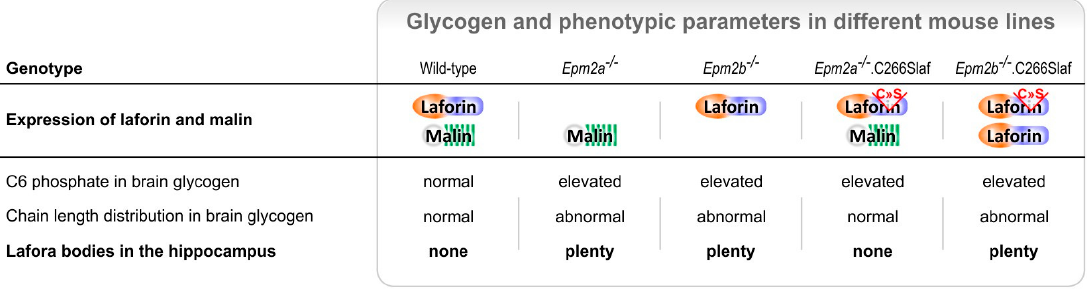
Figure 2. Prevention of LBs depends on the presence of malin but not on laforin’s phosphatase activity. The phenotypic features (C6 phosphate and chain length distribution, CLD) of brain glycogen as well as LB occurrence in the hippocampus are summarized for different LD-related mouse lines. Overexpression of phosphatase inactive laforin (C266S mutation in the DSP domain) leads to glycogen hyperphosphorylation but prevents both CLD abnormality and LB accumulation provided malin is functional. Hyperphosphorylation per se does not cause LB formation and accumulation.